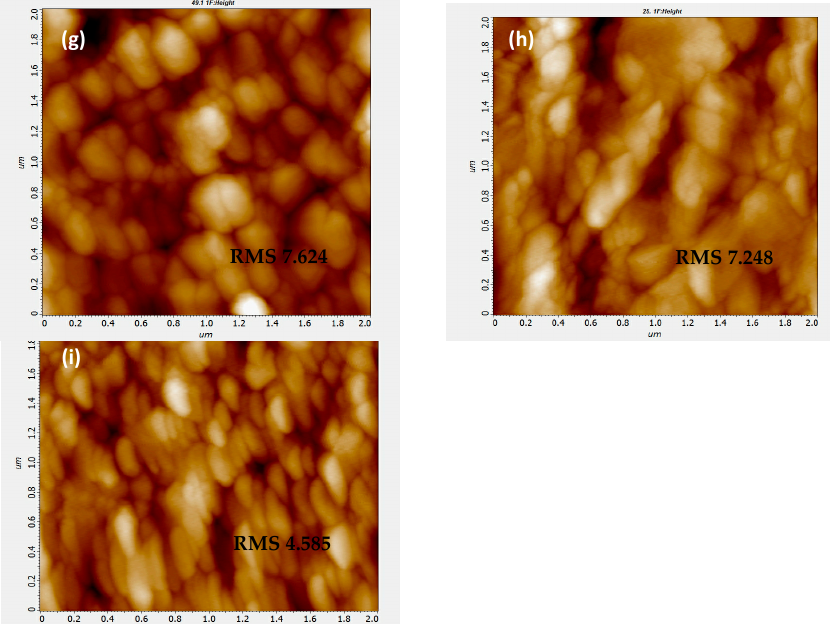
Figure 2. SEM images of MAPbI 3 films at different MA treatment times: ( a ) 0 s, ( b ) 5 s, ( c ) 10 s, ( d ) 15 s, ( e ) 20 s, ( f ) 30 s. Tapping-mode AFM height images of perovskite films treated with MA gas at different times: ( g ) 0 s, ( h ) 5 s, ( i ) 10 s.